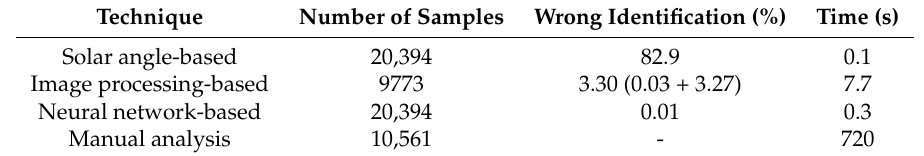
Table 1. Performance parameters for the three types of automatic identifications and the manual